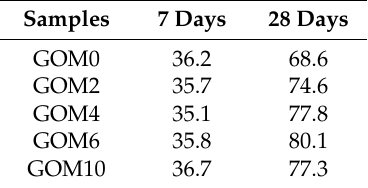
Table 8. Estimated compressive strength f s of mortars, MPa.